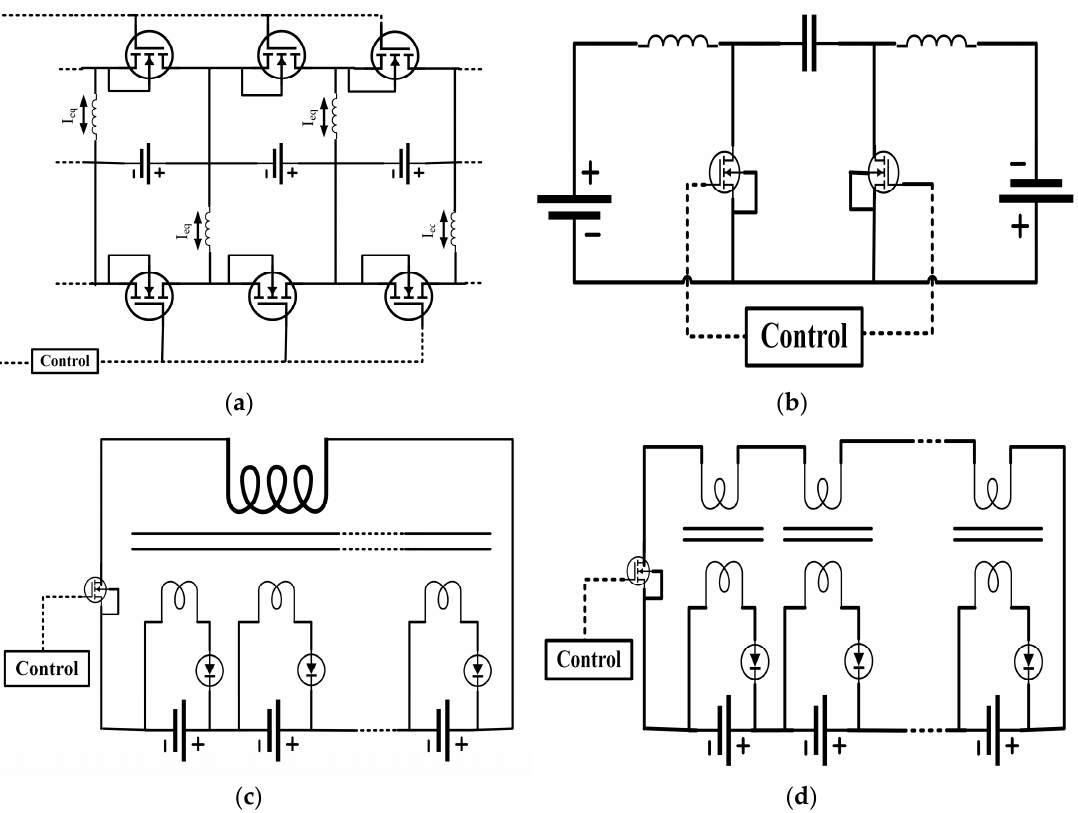
Figure 28. Inductive equalizer configurations: ( a ) Basic; ( b ) Cuk; ( c ) Transformer based; ( d ) Multiple transformers based. Excess energy is transferred to lower energy cells by using inductors. Table 8. Advantages and disadvantages of different equalizer types. Data from [46–52].